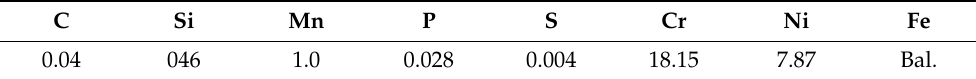
Table 1. Compositions of the alloy 304 used in the experiments (in wt%).